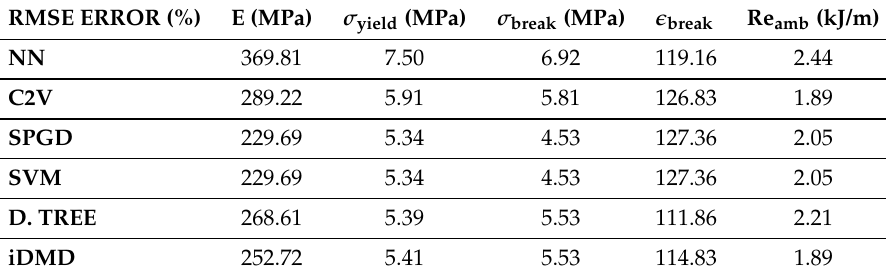
Table 3. RMSE error for the different regression techniques.